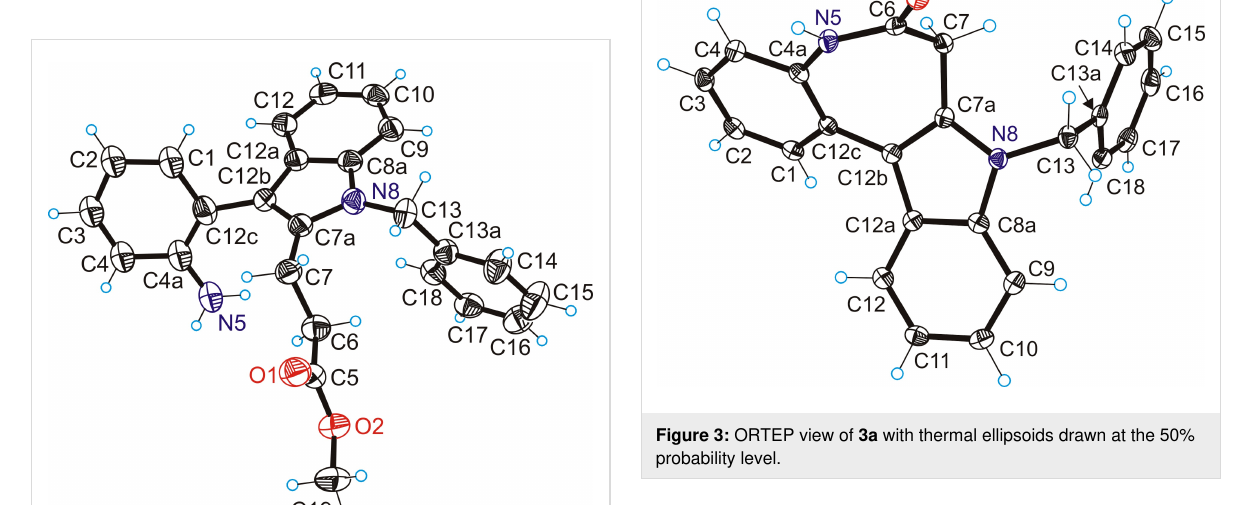
In addition, the generality of synthetic pathway (c) (Scheme 1) was confirmed by the successful preparation of two closely related analogues, namely 3b , bearing a bromo substituent